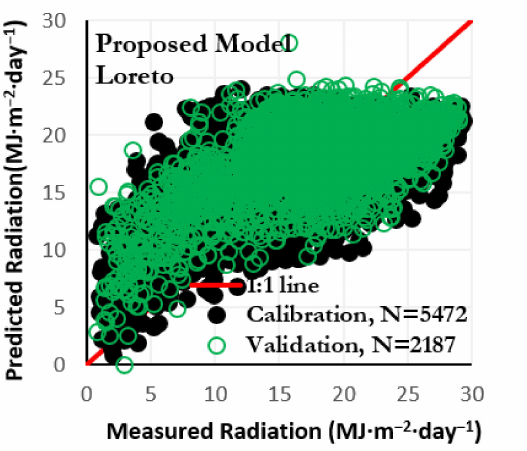
Figure 10. Solar radiation estimated by proposed model at Loreto station versus measured values in calibration and validation